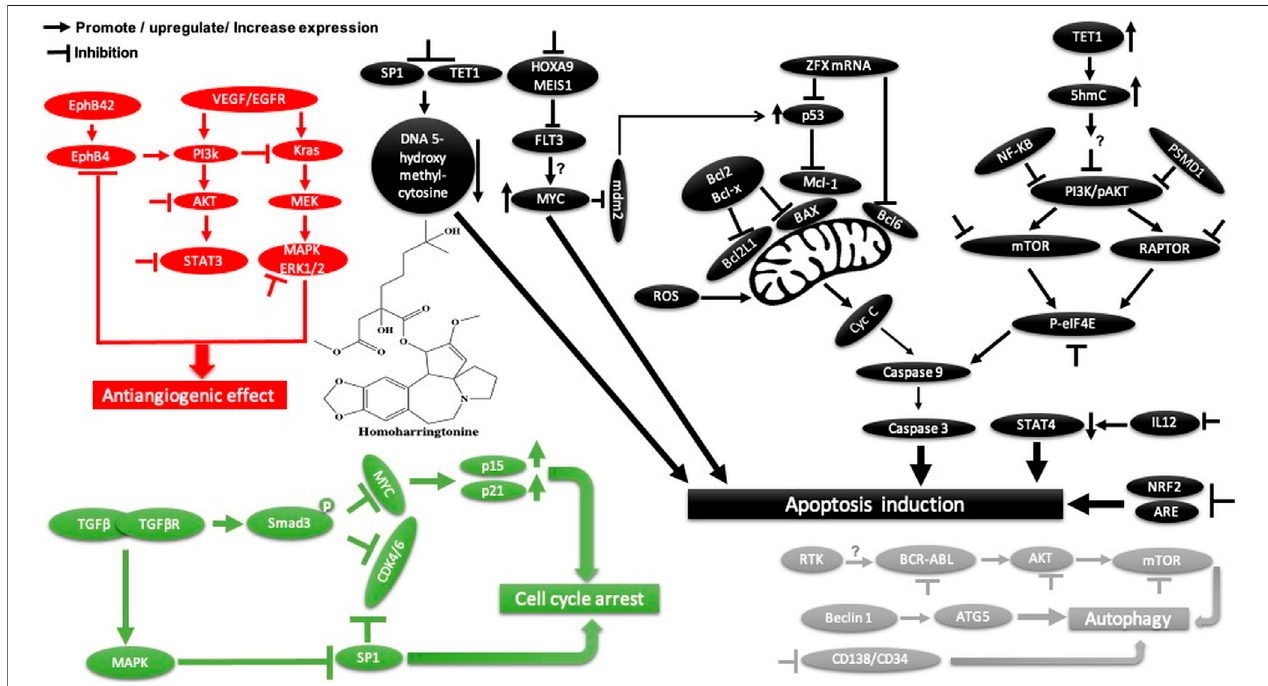
FIGURE 11 | Main mechanism of homoharringtonine against cancer in inducing apoptosis, autophagy, cell cycle arrest, and angiogenesis inhibition.